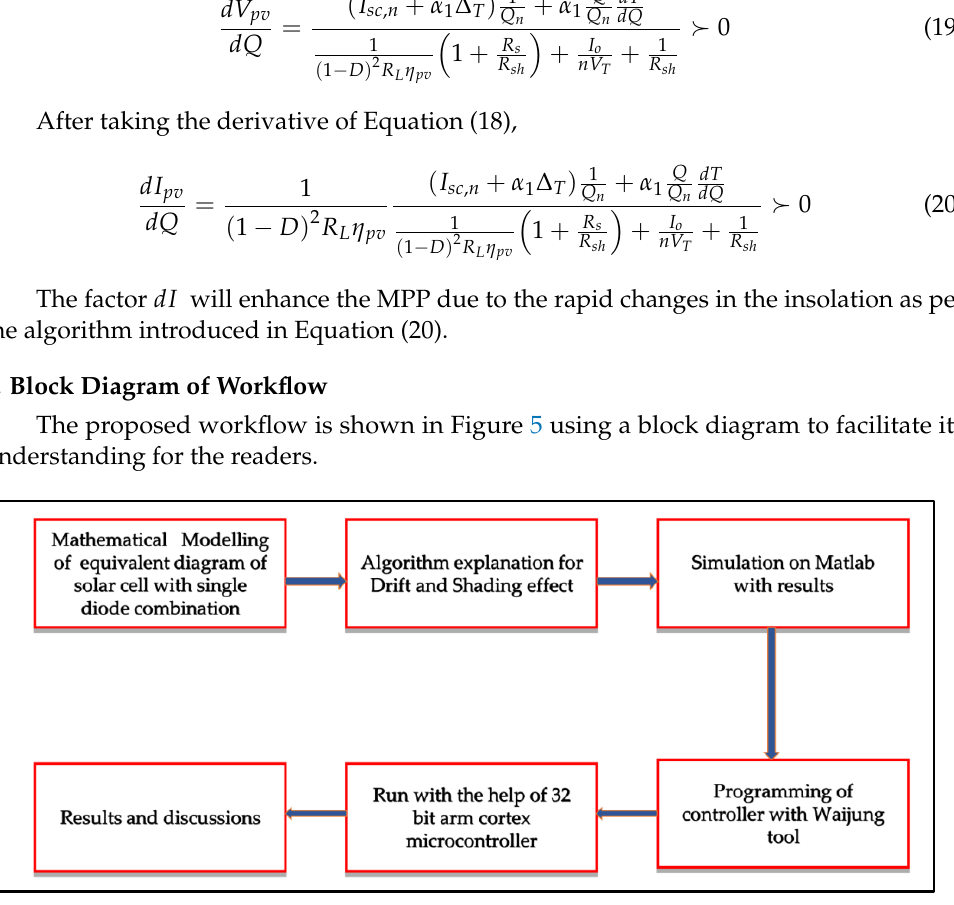
Figure 5. Workflow schematics.